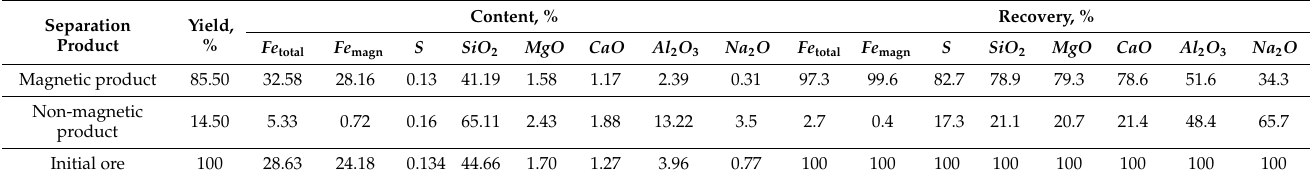
Table 6. Results of dry magnetic separation of mixture of iron ore samples, Kostomuksha and Korpangskoe deposits.